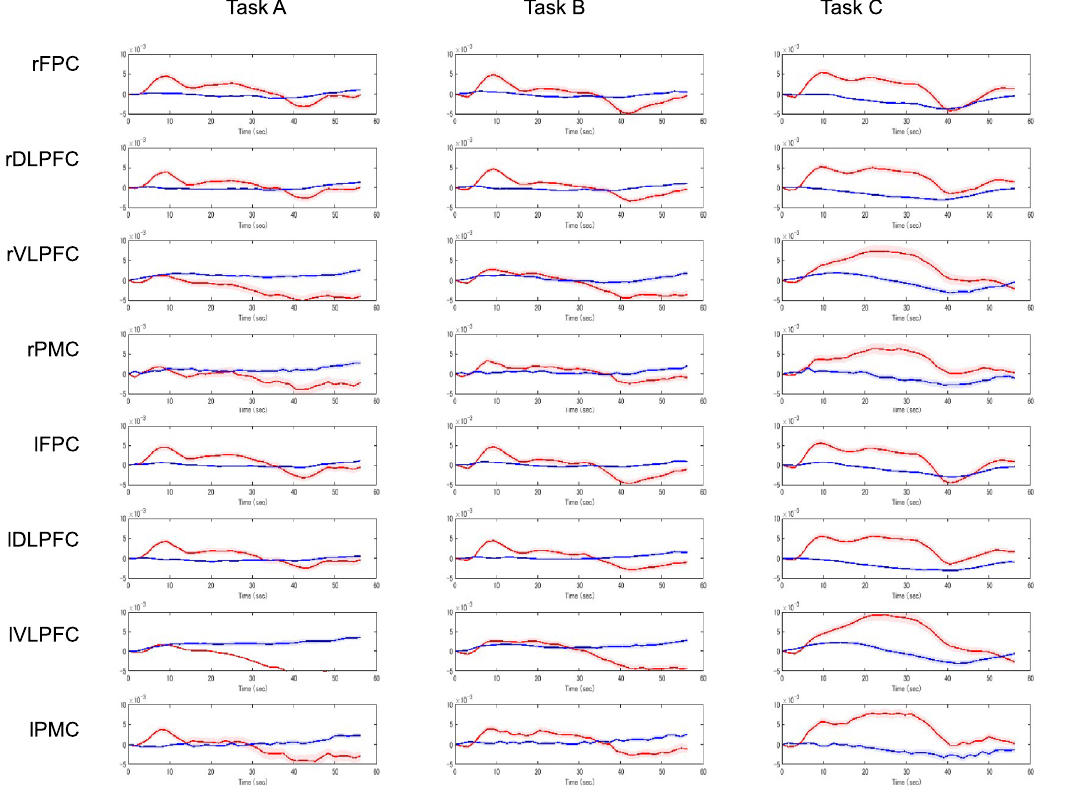
Figure 5. The averaged waveforms of oxygenated (oxy-Hb) and deoxygenated hemoglobin (deoxy-Hb) of each task for all regions of interest (ROIs). The red lines indicate the observed timelines of the oxy-Hb signal, and the blue lines indicate the deoxy-Hb signal. The first 29.5 s indicate the task block period, and the second half indicates the rest